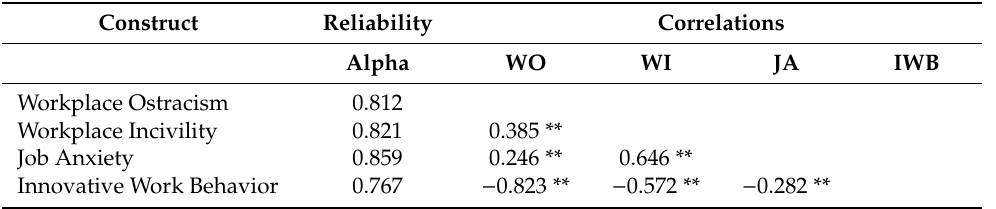
Table 2. Construct Reliability and Correlation.